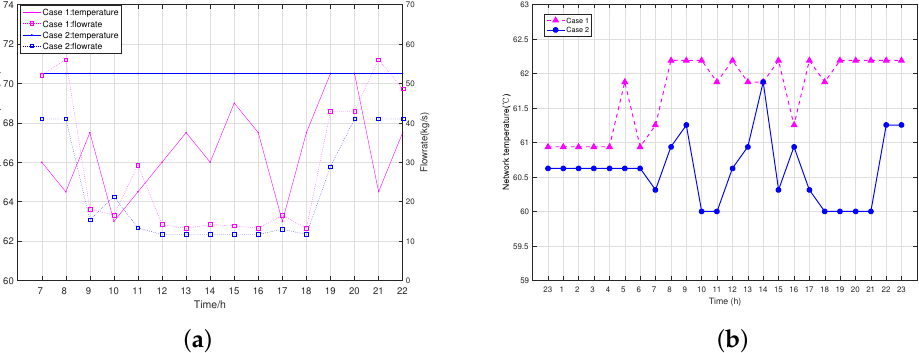
Figure 14. The operation result of WHB from the perspective of flowrate and temperature analysis. ( a ) the temperature and flowrate results of WHB; ( b ) the mixed temperature in hot networks.